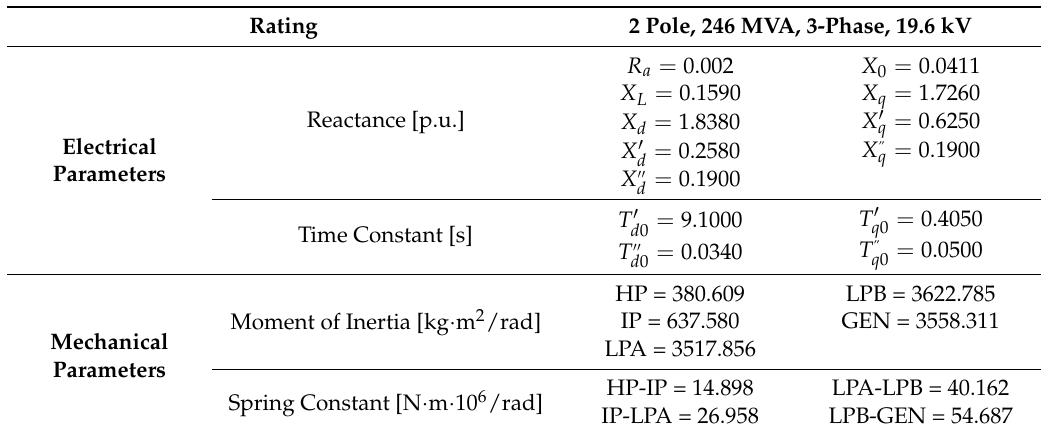
Table A1. 154 kV turbine-generator parameters.